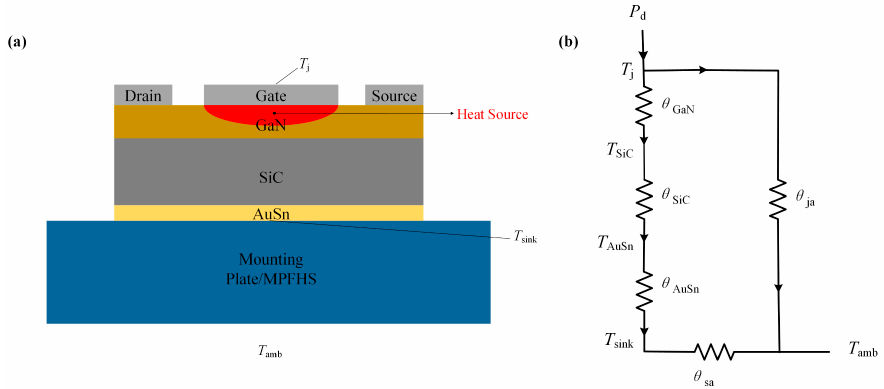
Figure 5. Thermal resistance model: ( a ) material system for the test module; ( b ) thermal resistance circuit for calculation and analysis.